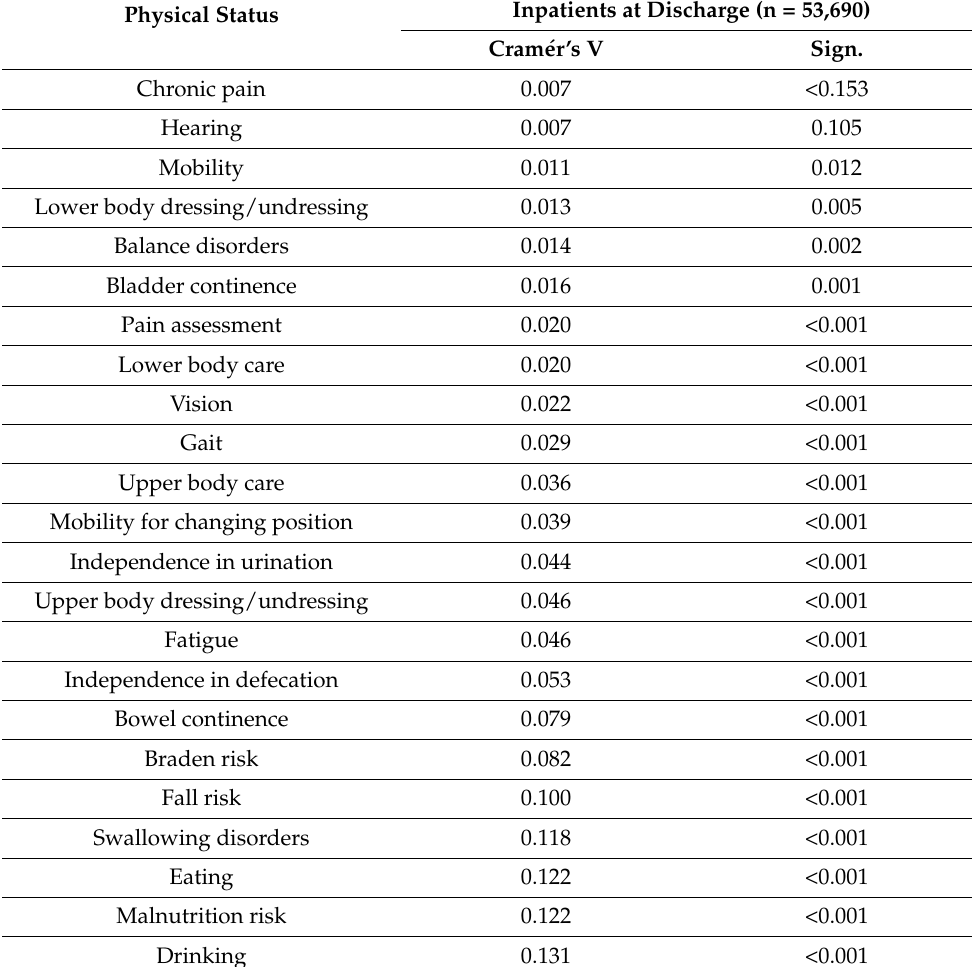
Table 4. Associations between polypharmacy and physical status among geriatric inpatients at discharge (n =